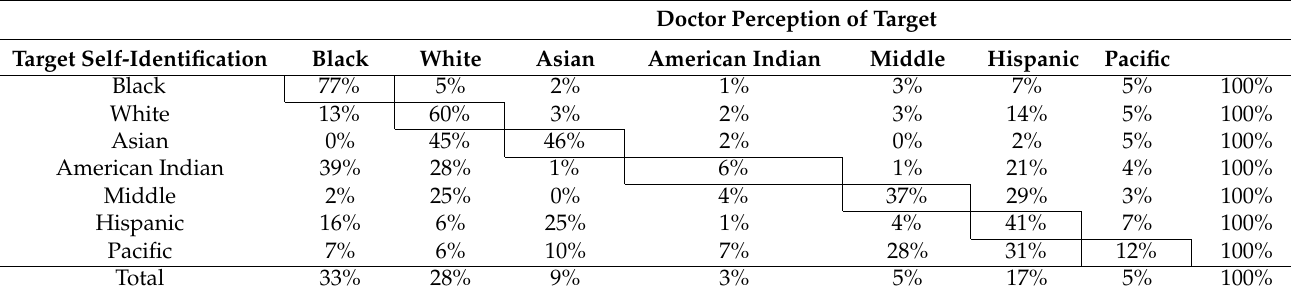
Table 7. Doctor identification of target by target self-identification. Doctor Perception of